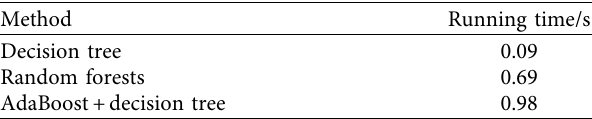
Figure 4: Prediction of plant index during cotton topping based on AdaBoost+decision tree. (a) Prediction of cotton plant height. (b) Prediction of the number of fruiting branches. (c) Prediction of the number of flower buds. Table 5: The comparison table of running time of each algorithm.